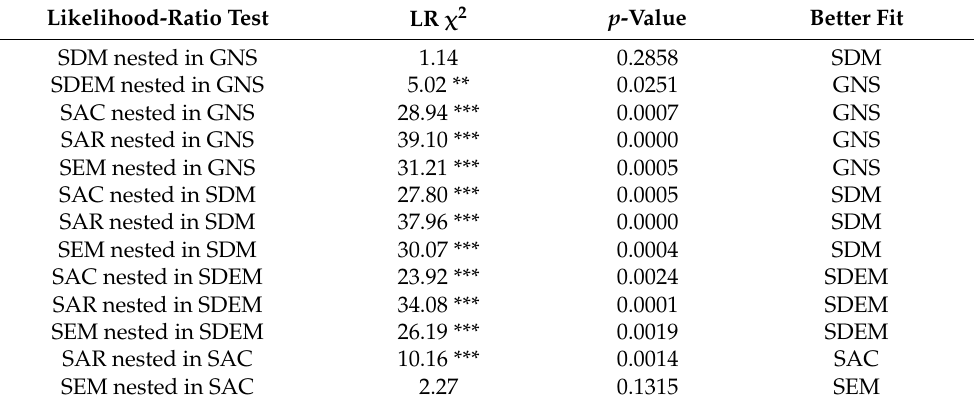
Table A3. Likelihood-ratio (LR) tests for different used spatial panel models.